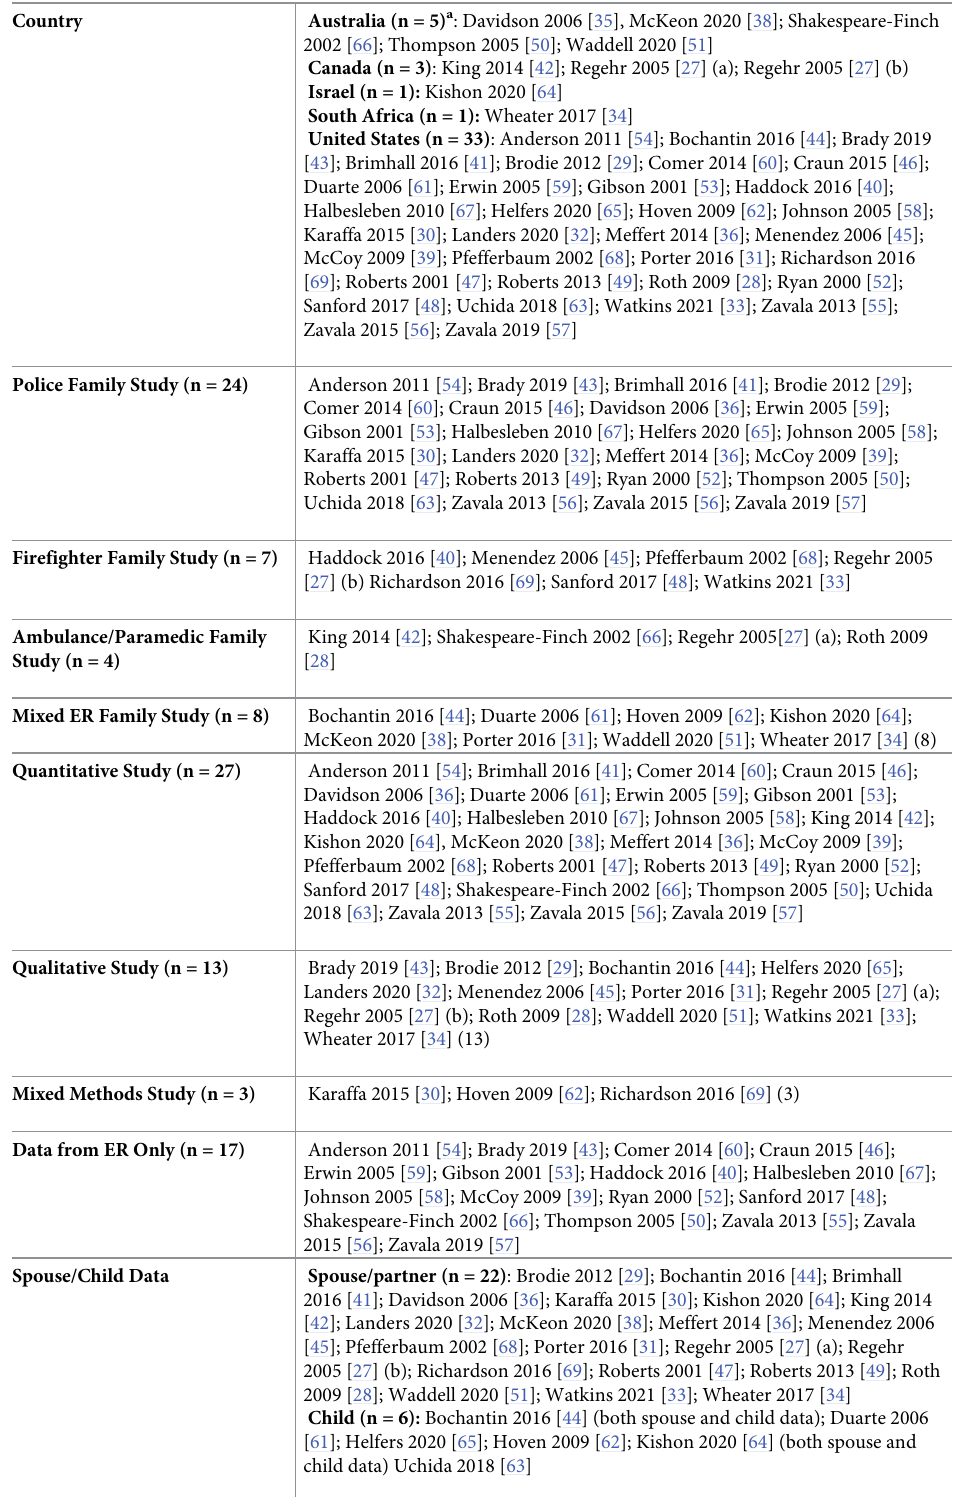
Table 1. Study characteristics